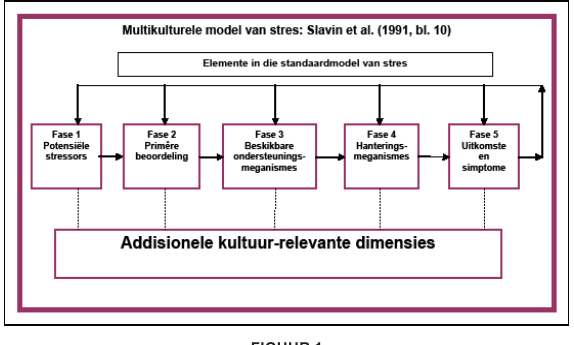
Figuur 1 ’n Grafiese voorstelling van ’n multikulturele model van